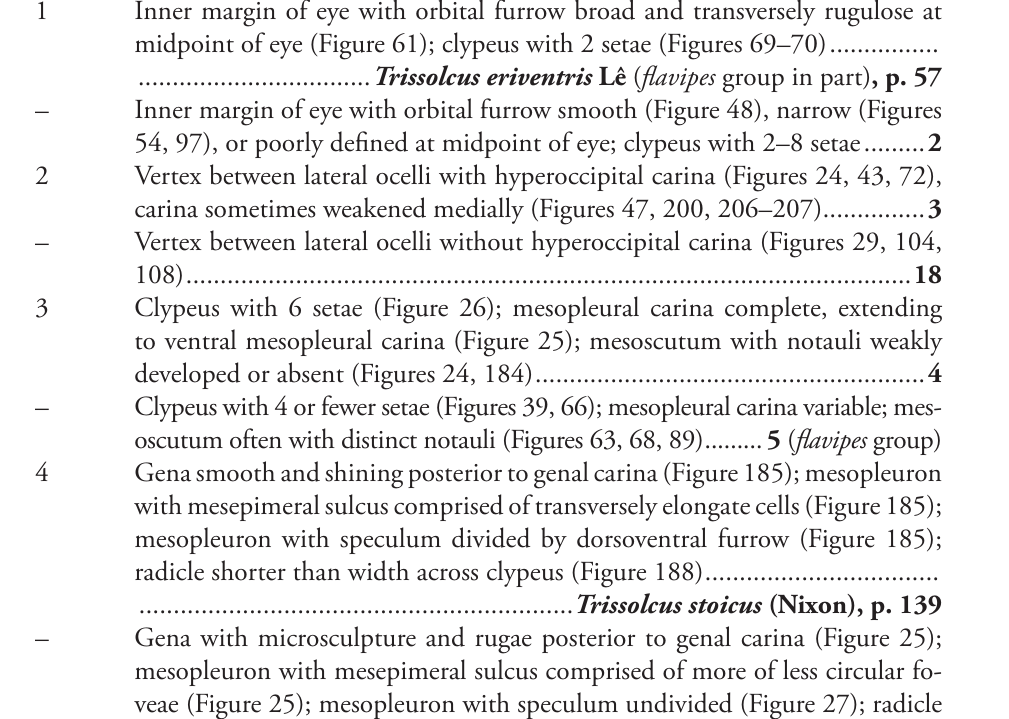
At intersection with malar sulcus, orbital furrow absent or without a defined medial margin (Figures 42, 44, 65, 69–70, 73–76) ................................... 14 Mesoscutum with median mesoscutal carina (Figure 51) .............................. – Mesoscutum without median mesoscutal carina (Figures 89, 195, 200) ...... 8 8 Mesopleuron with episternal foveae distant from postacetabular sulcus and mesopleural pit, often weakly indicated (Figure 202); vertex with hyperoccipital carina weakened medially (Figure 200) ..... Trissolcus tumidus (Mayr), p. 148 – Mesopleuron with episternal foveae forming a continuous line of cells from postacetabular sulcus to mesopleural pit (Figures 37, 88, 133, 197, 219); vertex with hyperoccipital carina uniform and robust (Figures 72, 89) ........